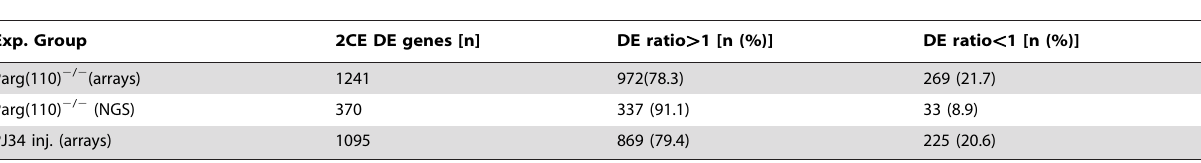
Table 2. Genes with differential expression in 2-cell